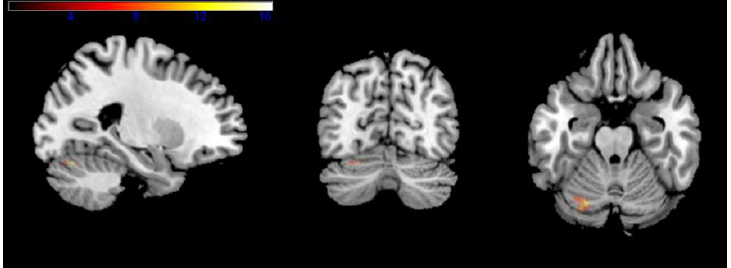
Figure 2. Effect of Ai-Chi on the high working memory load brain activation in an n-back task. Maximum intensity projections in three planes of the brain, depicting areas of significant activation (uncorrected, p < 0.001, k > 10) in a one-tailed-t statistic contrasting MR signal. The color scale shows t-values to the right. Table 3. N-back activation. Table presents regions of activation resulting from a paired t-test threshold to a value of 0.05, k > 10, uncorrected. x, y, z are MNI coordinates for maximum Z score of Peak-level; 2 > 0-back = high working memory load. Peak MNI Coordinates (mm) Peak-Level Label (AAL) 2 > 0-back #